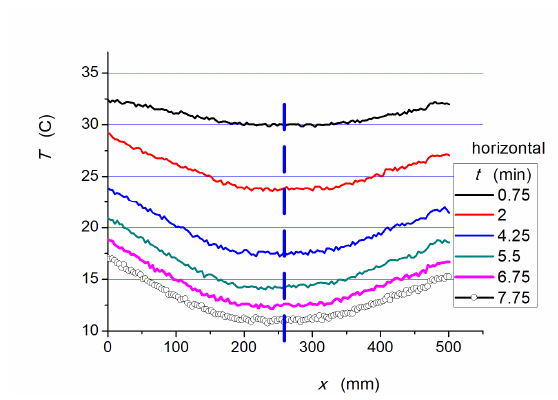
Fig. 3. Temperature distribution along horizontal x coordinate (see Fig. 2).